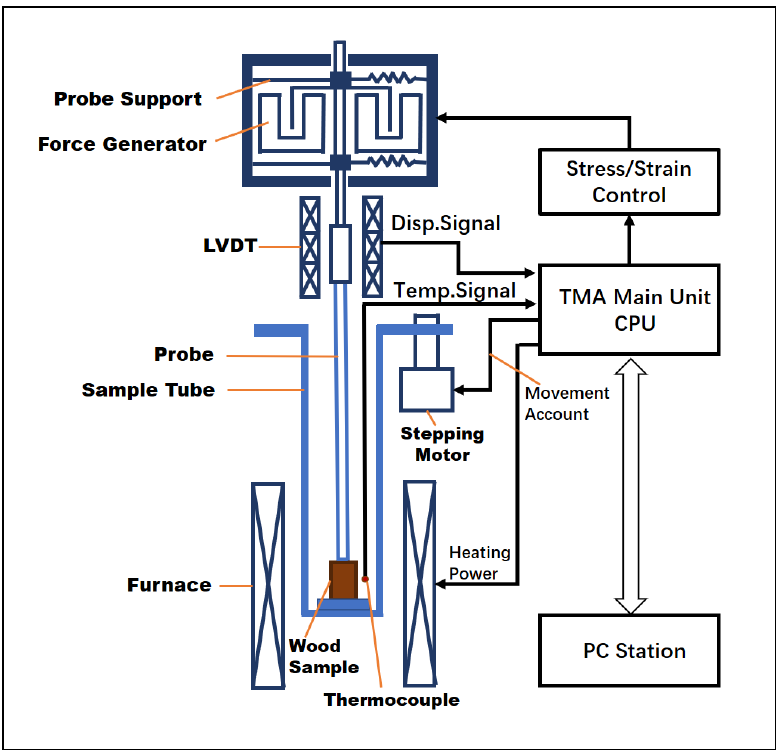
Figure 1. Schematic diagram of TMA (modified following an original drawing provided by HITACHI TMA7100 operation